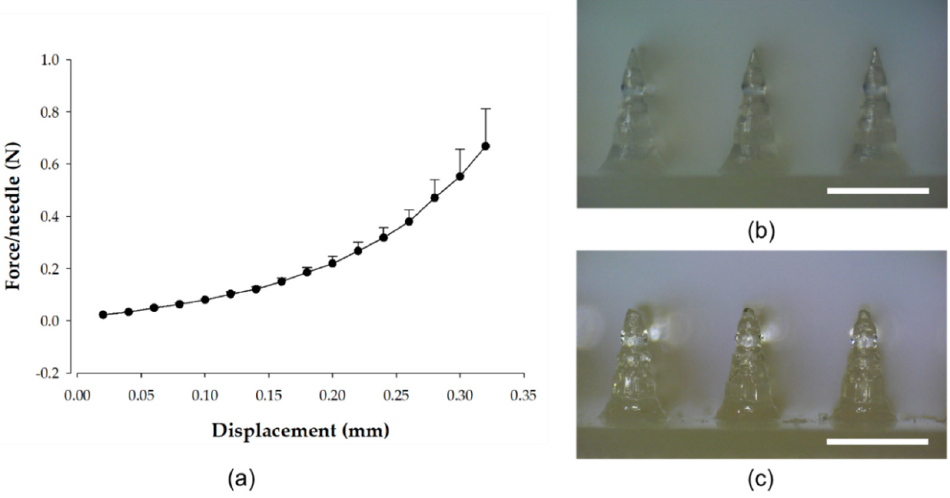
Figure 6. The mechanical behavior ( n = 3) of the microneedle patches ( a ) and the shape of the mi- croneedles ( b ) before and ( c ) after compression applied by a vertical force. The scale bars represent 1